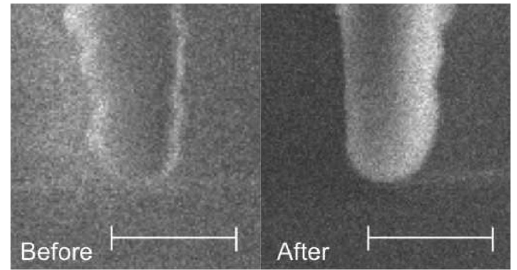
FIG. 9. The SEM image of a quartz tip shows that the tip shape and its radius of curvature ( ∼ 40 nm) do not change much before and after the experiments of more than 100 approach-retraction processes. The scale bar is 200